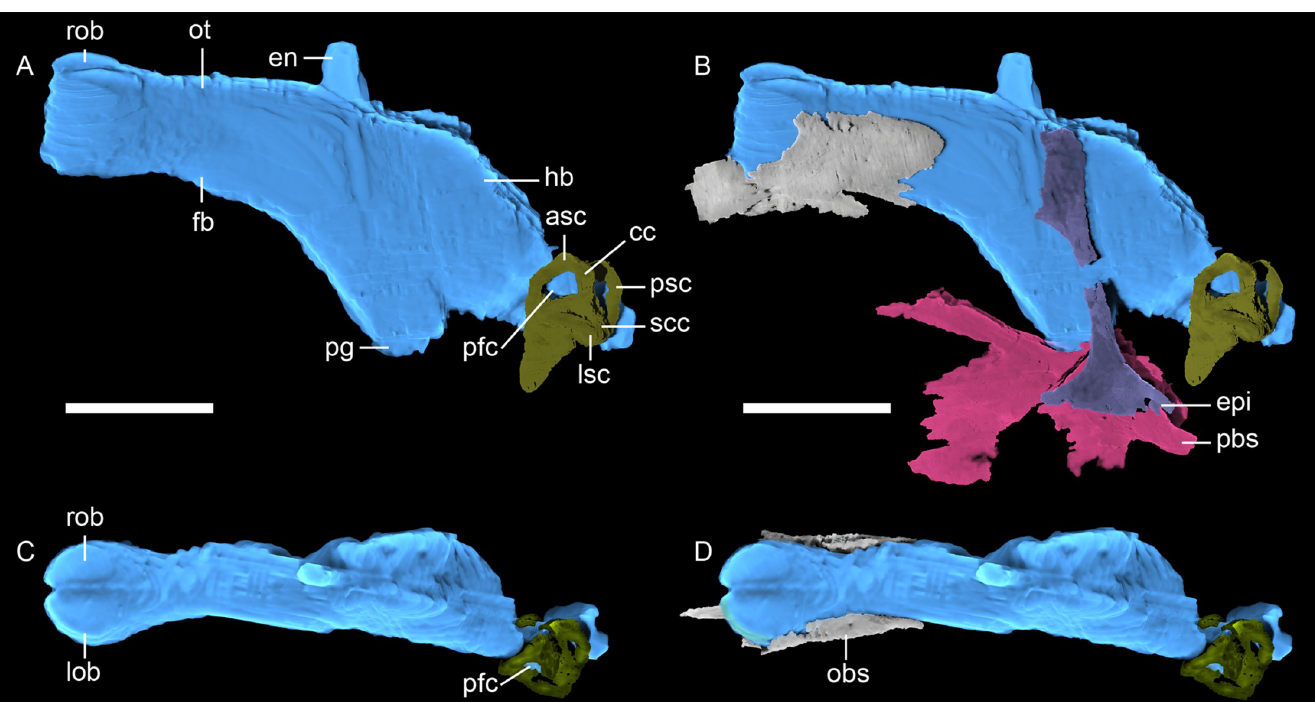
Fig 9. Neutron CT reconstruction of MB.R.999: brain endocast from (A and B) left lateral and (C and D) dorsal. Abbreviations: asc, anterior semicircular canal; cc, common crus; en, epiphyseal nerve; epi, epipterygoid; fb, forebrain; hb, hindbrain; lob, left olfactory bulb; ot, olfactory tract; pbs, parabasisphenoid; pfc, paraflocculus; pg, pituitary gland; psc, posterior semicircular canal; rob, right olfactory bulb; scc, secondary common crus. Scale bars = 2 cm.